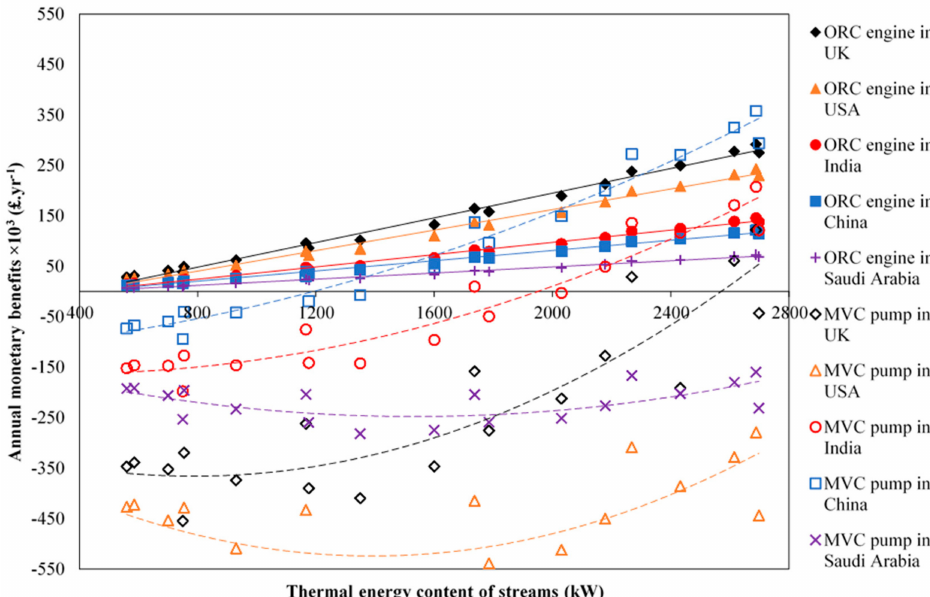
Figure 14. Annual monetary benefits resulting from use of ORC engines and MVC heat pumps in various countries as a function of the thermal-energy content of the streams when utilizing the thermal energy available in the streams listed in Table 5. The heat sink is at 25 ◦ C for the ORC engines, and 150 ◦ C (LP steam) is produced for the MVC heat